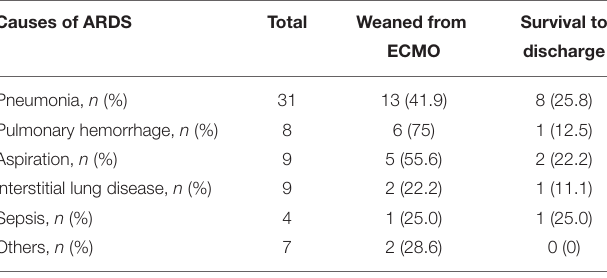
TABLE 4 | Outcomes for specific causes of ARDS in the immunocompromised patients. Causes of ARDS Total Weaned from Survival to